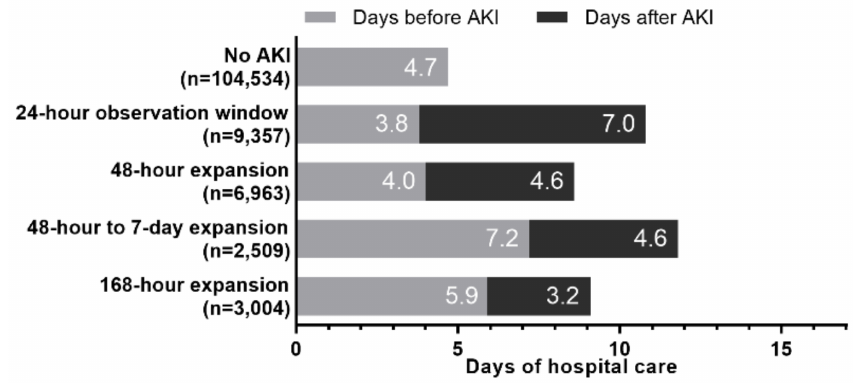
Figure 4. Days of hospital care before and after the detection of AKI by observation window expansion ( n = 126,367). AKI, acute kidney injury; KDIGO, Kidney Disease: Improving Global Outcomes. The days before AKI were calculated as days from hospital admission to first detection of AKI. If AKI was not detected, the days before AKI were equal to the entire length of hospital stay. Days after AKI were the number of days from first detection of AKI to hospital discharge. Days after AKI does not exist for patients who did not develop AKI; therefore, adjusted regression could not be used, and unadjusted data are presented in this